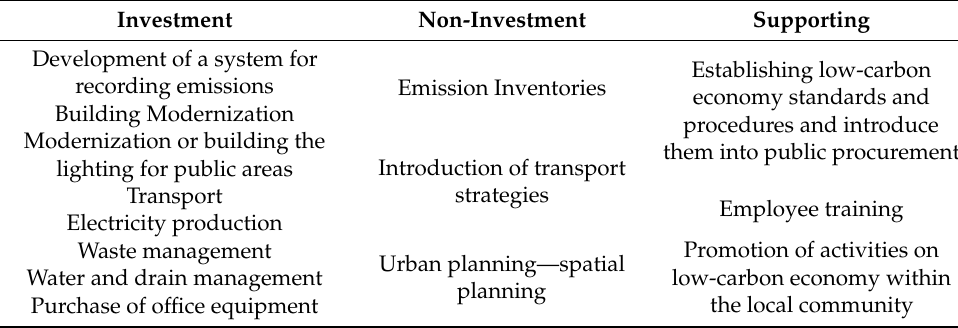
Table 1. City’s activities for a low-carbon economy. Investment